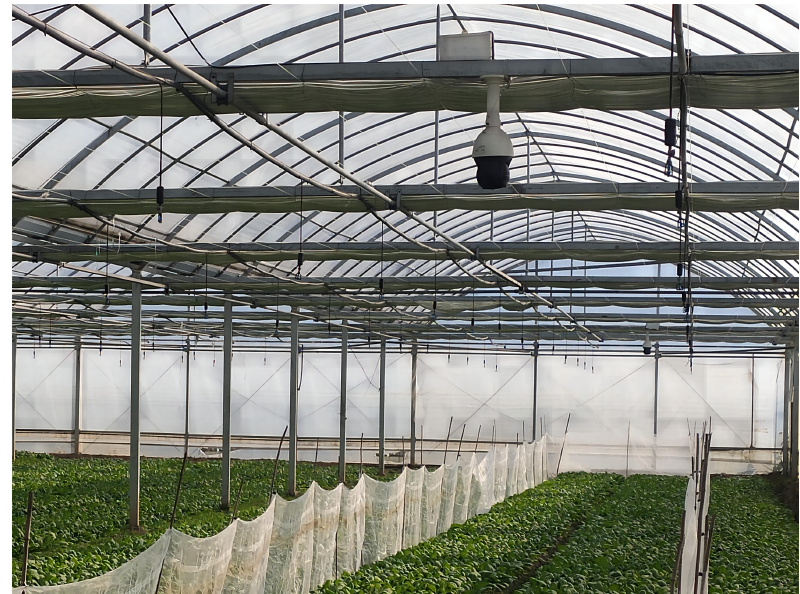
Figure 1. Installation of the camera in the greenhouse. A total of 362 images with a resolution of 1920 × 1080 px were collected, including the morphological changes of leafy greens from bud to maturity. Taking the growth cycle of the fastest-growing green leafy vegetables, for example, which were sown in spring. Based on different forms of leafy greens, we divided them into nine growth stages at an interval of 4 days and classified them as categories, as shown in Figure 2. All images were manually labeled based on the photography date and the morphological characteristics of leafy greens and used as a data set. Finally, the data set was divided into the training set, verification set, and testing set at a 3:1:1